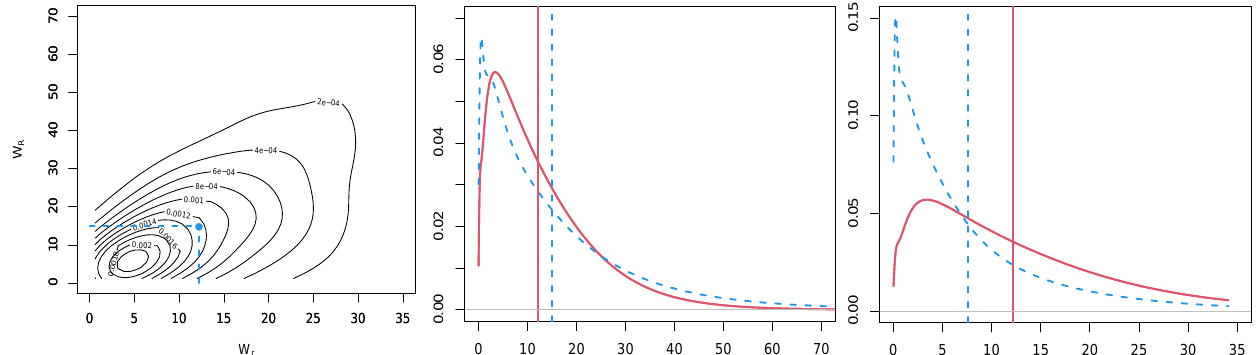
Figure 3. ( Left ) Contour plot showing the joint probability distribution of ( W r ∗ , W R ) and its mean vector. ( Middle ) Comparison of the kernel density estimates of the density functions of W R (dashed line) and W r ∗ (solid line), jointly with their mean values (vertical lines). ( Right ) Comparison of the kernel density estimates of the distributions of W r ∗ (solid line) and ˜W r (dashed line), jointly with their mean values (vertical